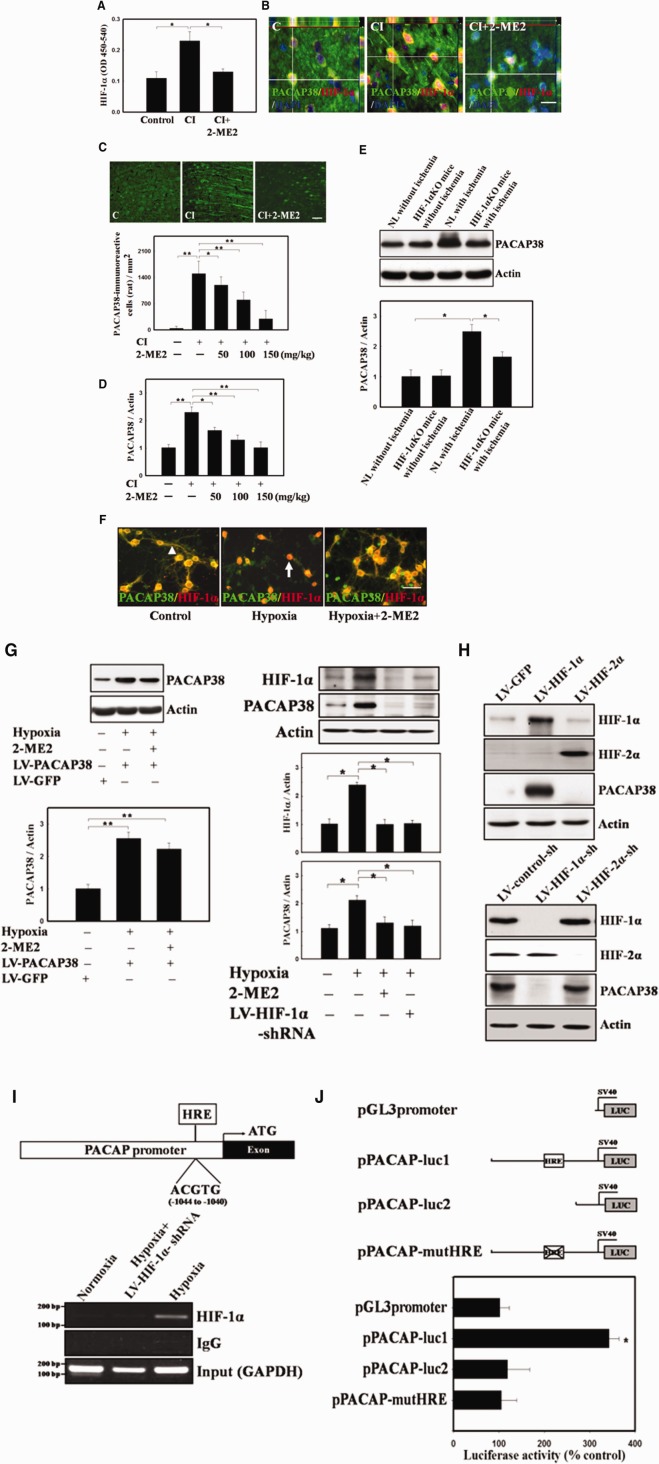
Upregulation of PACAP38 after CI and hypoxia via induction of HIF-1α in vivo and in vitro. (A): Nuclear HIF-1α activity increased in the brains of CI rats and was blocked by intraperitoneal administration of 2-ME2 (100 mg/kg). (B): Increasing numbers of PACAP38+ cells colocalizing with HIF-1α+ cells in the ischemic penumbral area were abolished by injection of 2-ME2 (C, nonischemic control). 2-ME2 injection inhibited the HIF-1α translocation into nucleus in the ischemic brain. (C): PACAP38 immunoreactivity decreased in a dose-dependent manner in the presence of 2-ME2 after CI (C, nonischemic control). (D): Western blot analysis of PACAP38 in the ischemic rat brain, quantitative data from Western blots are shown. (E): In HIF-1α KO mice, CI did not significantly induce PACAP38 upregulation as compared with NL. Quantitative data from Western blots are shown. (F): Double immunofluorescence for HIF-1α and PACAP38 in primary cortical cultures (PCCs) in the absence and presence of a 16-hour pretreatment with 2-ME2 (10 µM) before hypoxia (nuclei or perinuclear area, arrow; cytosol, neurites arrowhead). (G): 2-ME2 specifically inhibited HIF-1α-induced PACAP38 expression but not lentiviral (LV-PACAP38) infection-induced PACAP38 expression (left panel). In addition, PACAP38 expression was downregulated by LV-HIF-1α-sh. (LV-GFP and LV-control-sh) were used as a nonspecific control under hypoxic conditions, right panel). (H): Modulation of PACAP38 expression in PCCs was found in genetic targeting of HIF-1α via lentiviral transduction (LV-HIF-1α or LV-HIF-1α-sh) at 1 hour after hypoxia compared to that of HIF-2α by western blot. (I): Schematic representation of the 5′-flanking PACAP genomic region with the promoter and first exon. The hypoxic-responsive element (HRE) binding site corresponds to nucleotides −1,044 to −1,040 (relative to putative transcription start site +1). Binding of HIF-1α to the PACAP promoter was detected with a chromatin immnuoprecipitation assay in PCCs subjected to hypoxia (LV-HIF-1α-shRNA was used as a negative control). (J): A luciferase reporter assay in hypoxia-treated cells transfected with pPACAP-luc1 as compared with a control construct (pPACAP-luc2) and an HRE-mutant construct (pPACAP-mutHRE). n = 8 per group. The mean ± SEM is shown. *, p < .05 and **, p < .01 vs. control. Scale bar = 50 μm. Abbreviations: CI, cerebral ischemia; DAPI, 4′,6-diamidino-2-phenylindole dihydrochloride; GFP, green fluorescent protein; HRE, hypoxic responsive element; HIF-1α, hypoxia inducible factor 1α; KO, knockout; 2-ME2, 2-Methoxyestradiol; NL, normal littermate; PACAP38, pituitary adenylate cyclase-activating peptide 38.